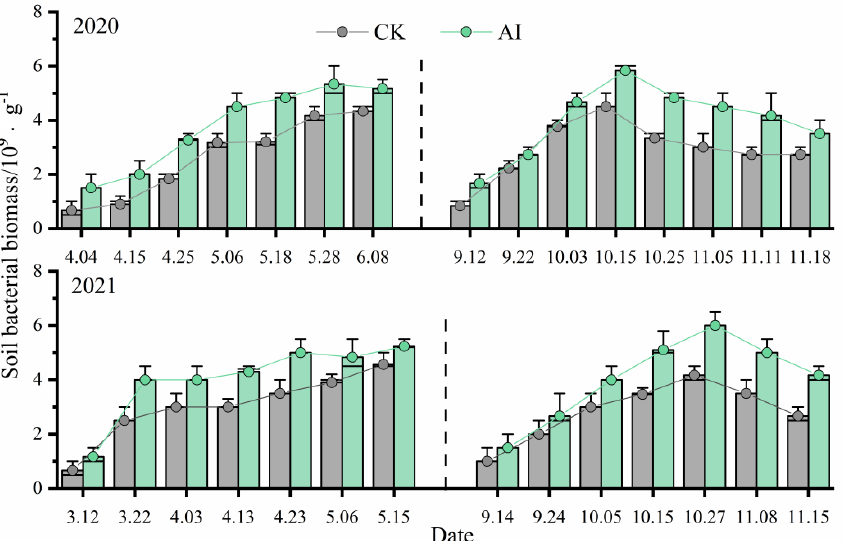
Figure 6. The dynamic change curve of soil bacterial biomass under different treatments (AI, aerated irrigation; CK, unaerated subsurface drip irrigation).